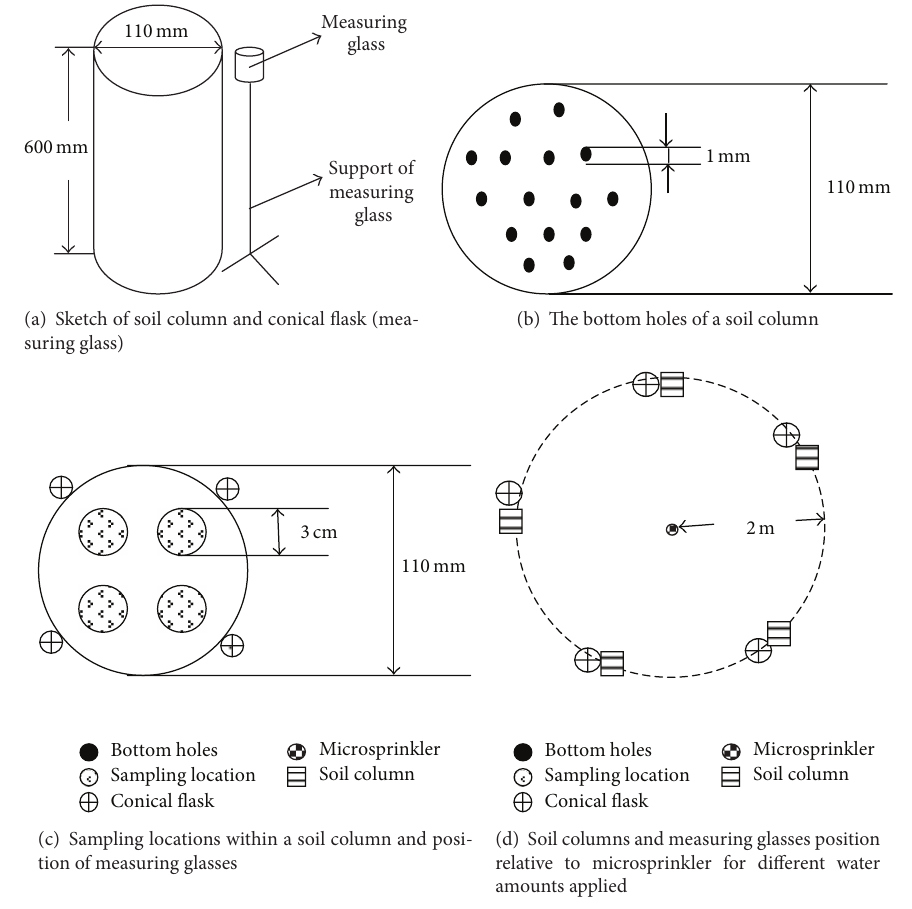
Figure1:Sketchoftheexperimentalsetupshowingthelocationofmicrosprinkler,soilcolumns,andmeasuringglasses,withdetailsofbottom holes and sampling location within a